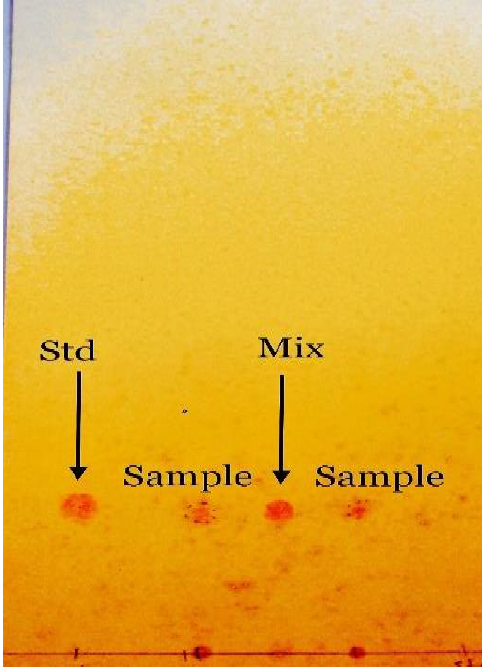
Figure 9. TLC of the band (sample) isolated by preparative TLC from fraction-1 (F-1) using silica gel GF 254nm as adsorbent and S 5K as a mobile phase. Detection by dragendorffʼs spraying reagent. Std : Abrine standard. Mix: abrine standard and sample mixture. 2-Melting point (M.P.)